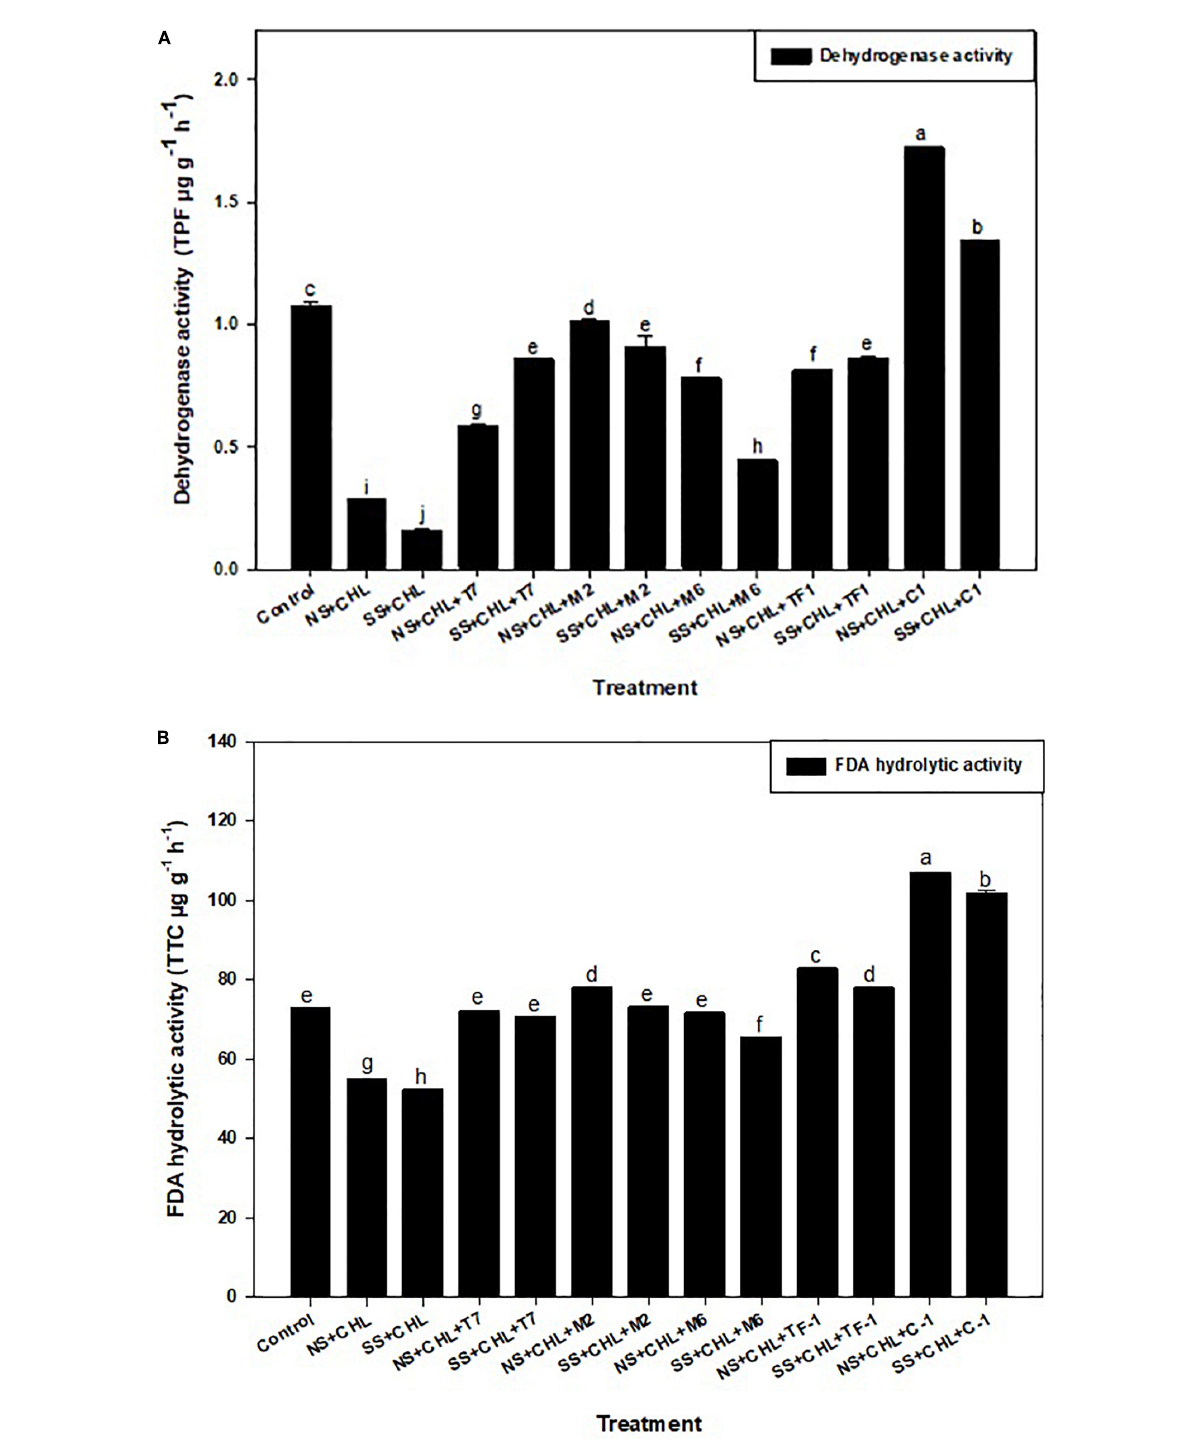
FIGURE4 (A) Dehydrogenase activity of the soil treated by different strains and developed consortium in sterile and natural conditions. The recorded data were the average of five replicates ( n = 5). Bars represent the standard error. Significant differences based on the analysis variance (ANOVA) are shown by different letters above the error bars, followed by the post-hoc DMRT test ( p ≤ 0.05) using the software SPSS. (B) Fluorescein diacetate (FDA) hydrolysis activity of the soil treated with different strains and developed consortium in sterile and natural conditions. The recorded data were the average of five replicates ( n = 5). Bars represent standard error. Significant differences based on the analysis variance (ANOVA) are shown by different letters above the error bars, followed by the post-hoc DMRT test ( p ≤ 0.05) using the software